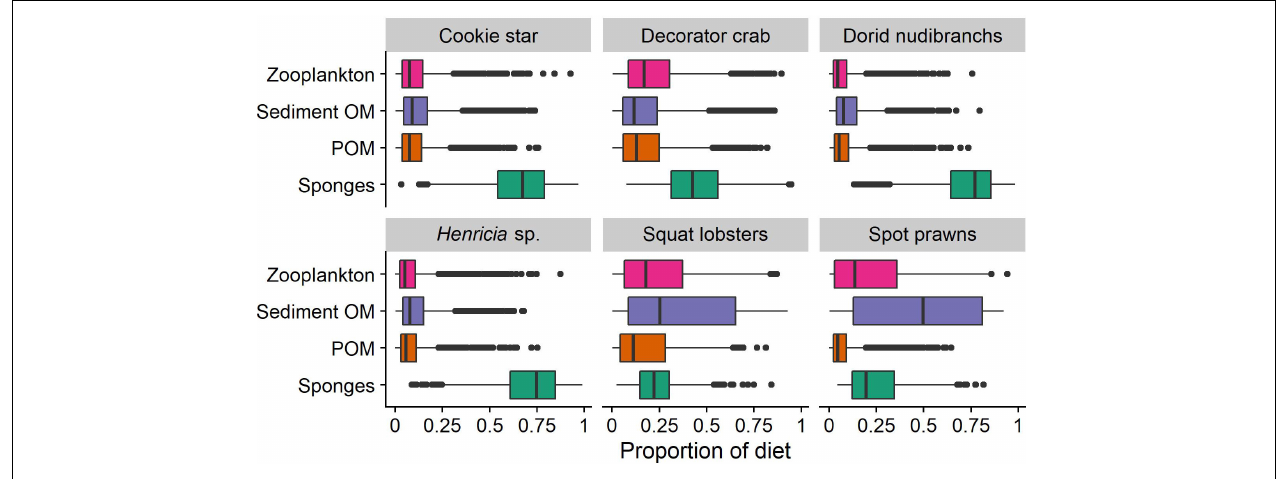
FIGURE 3 | Results of the stable isotope mixing model. Values represent the estimated proportion of each source in the diet of each consumer.